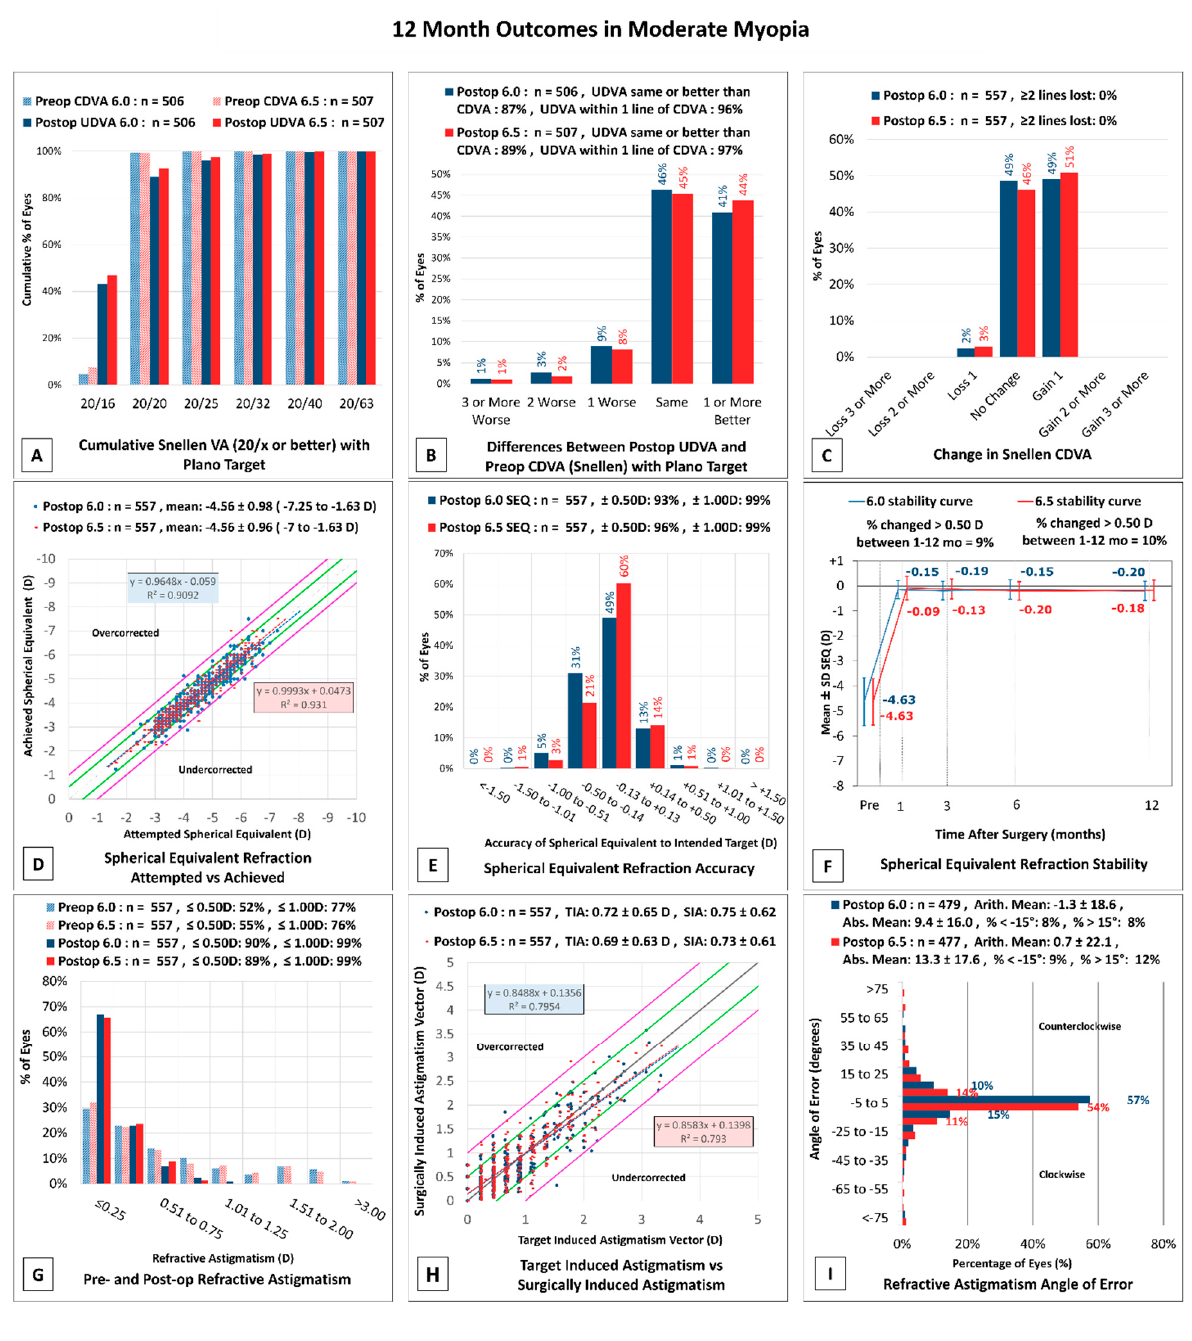
Figure A2. Standard reporting of visual and refractive outcomes for eyes at twelve months postoperatively between 6.0 and 6.5 mm in Moderate Myopia. ( A ) Cumulative preoperative CDVA and postoperative UDVA; ( B ) difference between preoperative CDVA and postoperative UDVA; ( C ) change in Snellen CDVA; ( D ) attempted vs. achieved MRSE; ( E ) accuracy of MRSE; ( F ) MRSE stability at one, three, six, and 12 months; ( G ) comparison of preoperative and postoperative manifest cylinder; ( H ) target-induced vs. surgically-induced astigmatism; ( I ) angle of error.